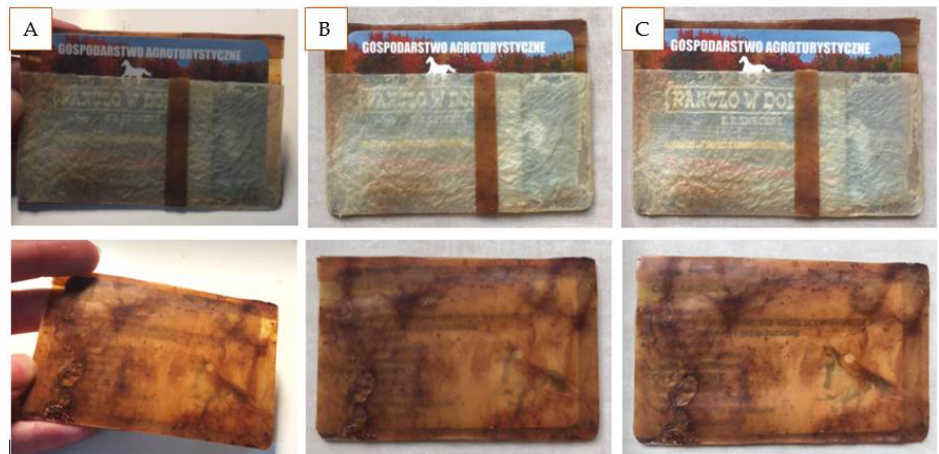
Figure 7. The card holder prepared as a prototype ( A ) and the changes in the material after 1 week ( B ) and 1 month ( C ).